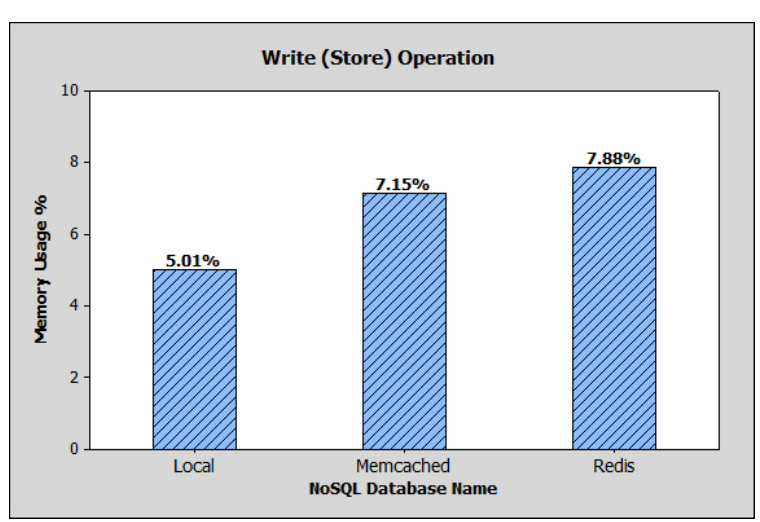
Figure 3. Memory usage with write operation (Single